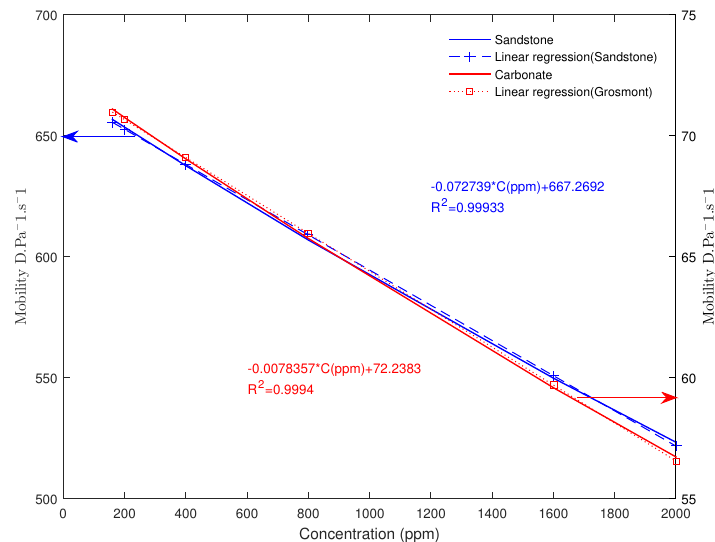
Figure 8. Simulated results of the variation of the effective mobility Eq. (13) function of the polymer Concentration.